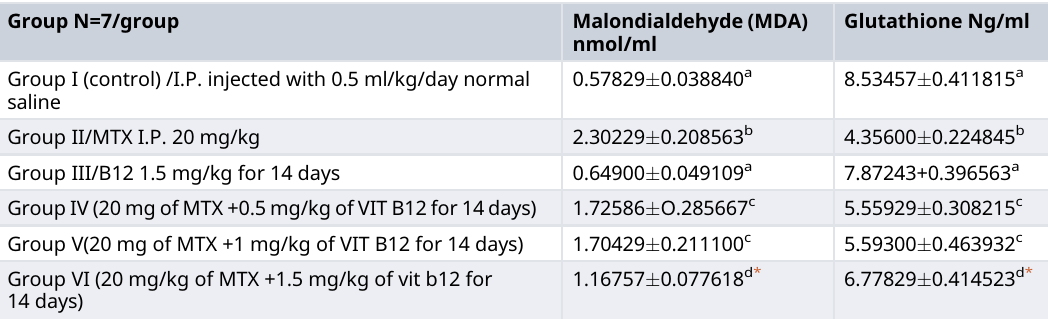
Table 1. Effect of cyanocobalamin on levels of malondialdehyde (MDA) and glutathione (GSH) within the kidney tissue homogenate of rats. Group N=7/group